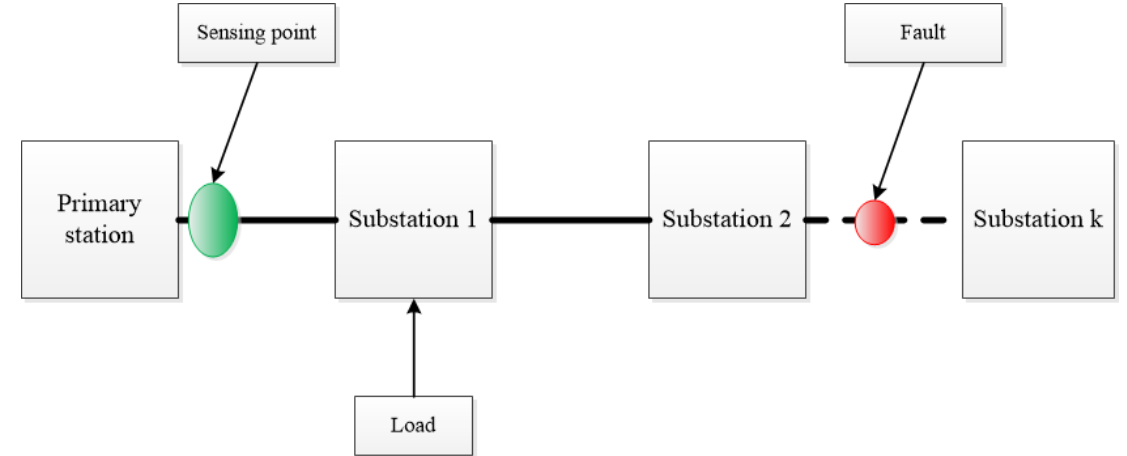
Figure 1. Block diagram of an electrical network.